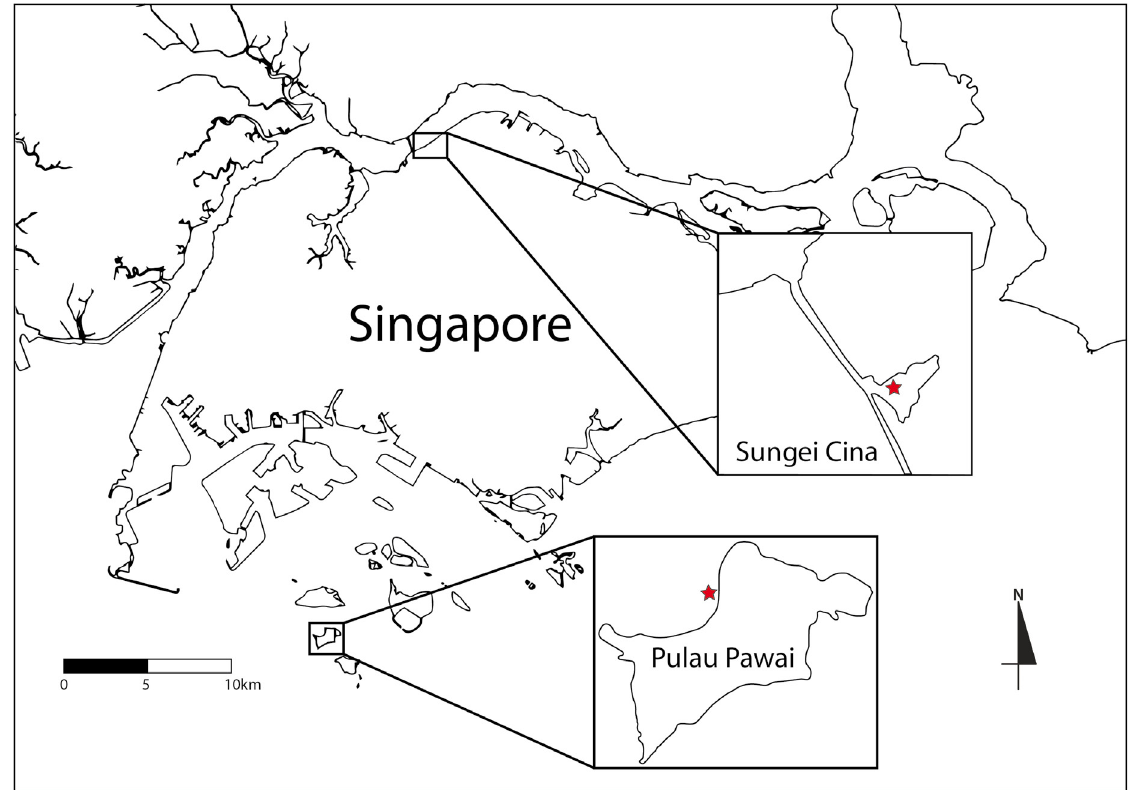
Fig. 1. Map of Singapore with locations of collecting sites: Sungei Cina and Pulau